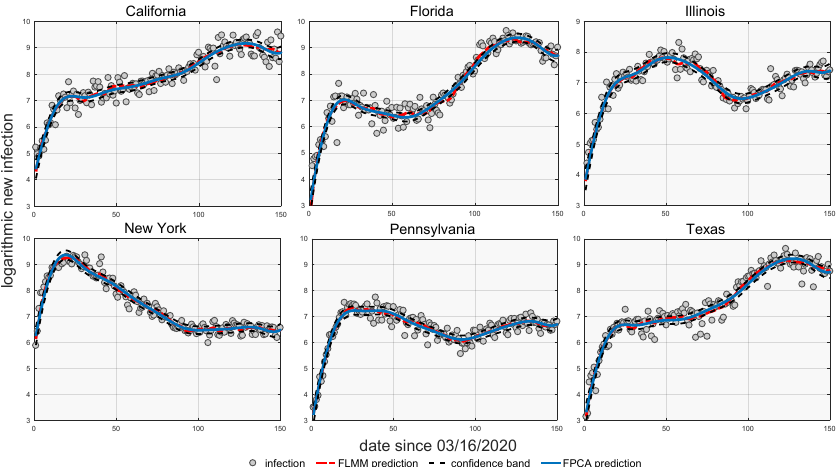
Figure 6. Predictions of the trajectories of six states via FPCA and proposed FLMM.